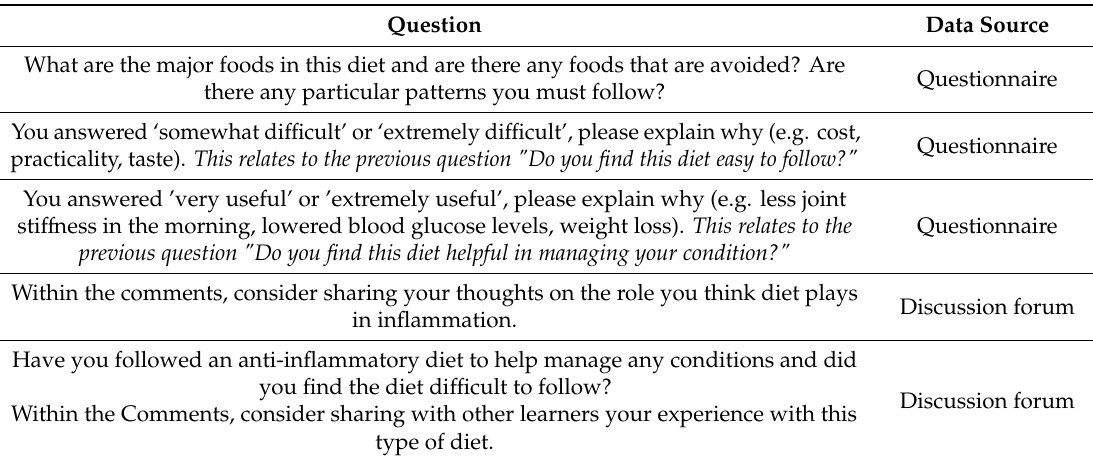
Table B1. Open ended questions used to gather qualitative data. Table A1. Open ended questions used to gather qualitative